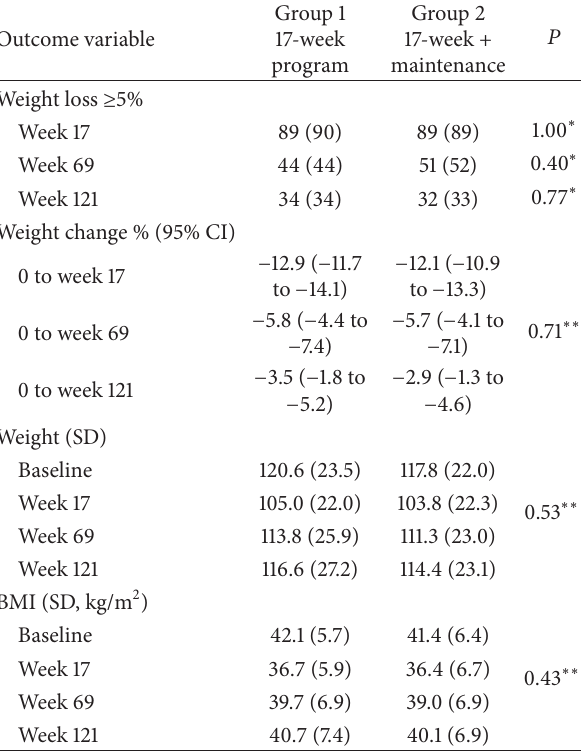
Table 2: Number (%) of patients with 5% or more weight loss, mean weight change, mean weight (SD), and BMI (SD) by treatment